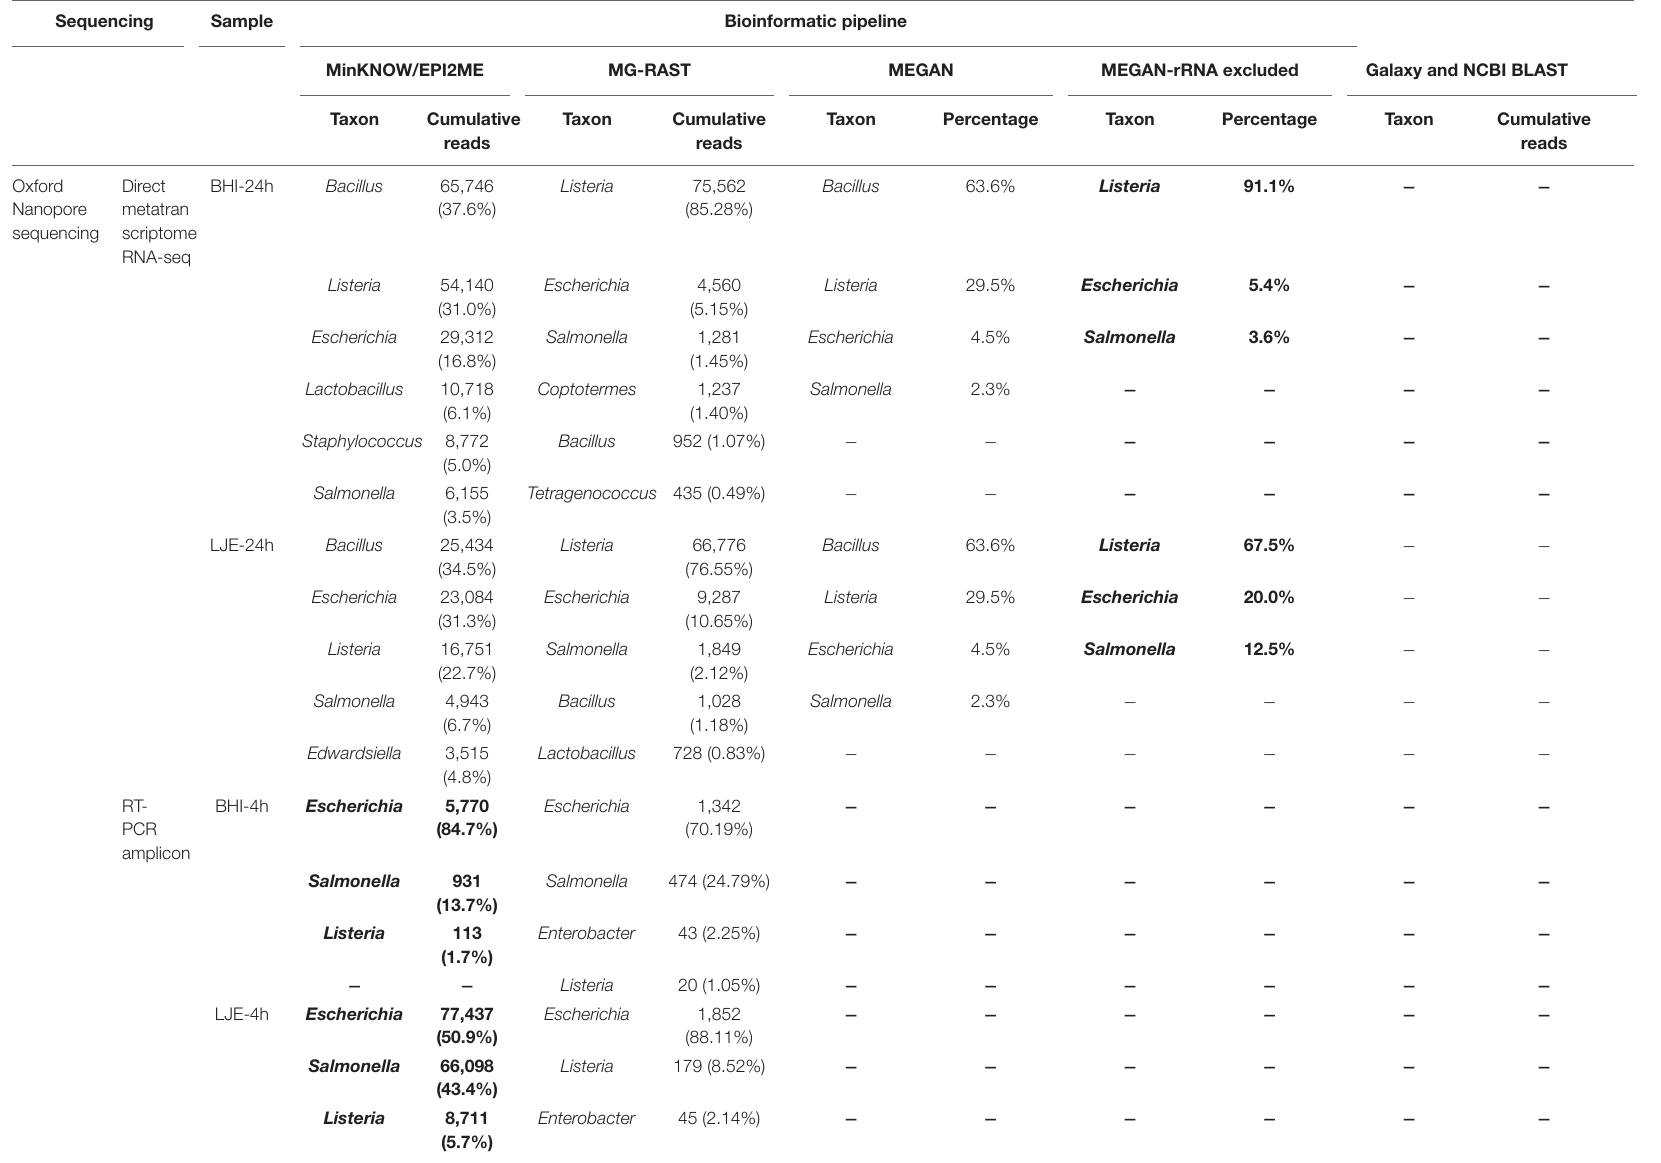
TABLE 2 | Results of MinION R9.4 Rev D direct metatranscriptome RNA-seq and RT-PCR amplicon sequencing, as well as NGS iSeq 100 i1 system for BHI and LJE samples collected from 4-hour and 24-hour culture with different initial growth concentration via different bioinformatic pipelines * .